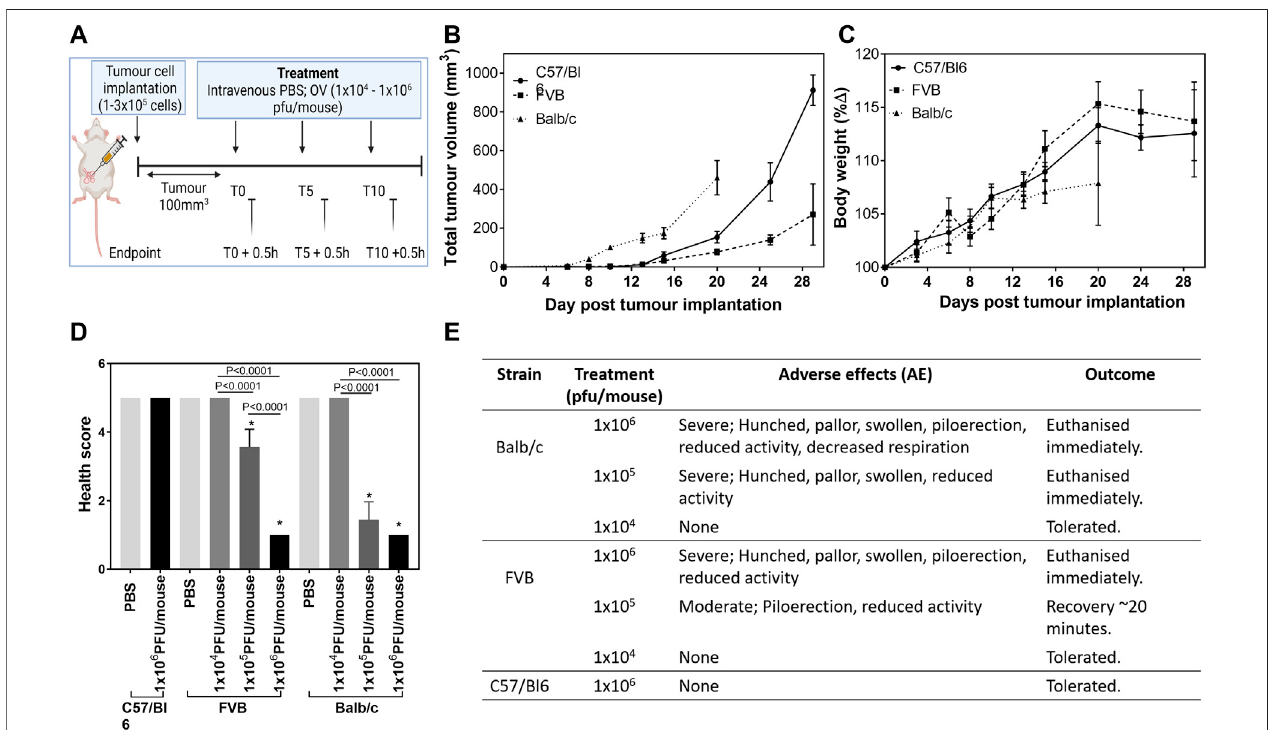
FIGURE1| Maximumtolerated dose ofHSV1716 ismousestrain-dependent. C57/Bl6, FVB,and Balb/c mice wereimplanted withmLuc-E0771,PyMT-TS1,and mLuc-4T1-Br breast cancer cells, respectively [ (A) , created using BioRender], and received a range of OV treatment (1 × 10 4 – 1 × 10 6 pfu/mouse) once average tumor volume had reached 100 mm 3 to determine the maximum tolerated dose (MTD) (B) . Mice receiving their MTD were culled 30 min post-treatment at each timepoint for analysis( n =3/grouppertimepoint).Healthwasmonitored bymeasuringbodyweight (C) ,anda fi nalhealthscorewascalculated (D) usingseverityanddurationof adverse effects seen during 30 min observation window (E) . Data are shown as mean ± SD. Statistical signi fi cance was determined by one-way ANOVA where p = p < 0.05 versus PBS group.